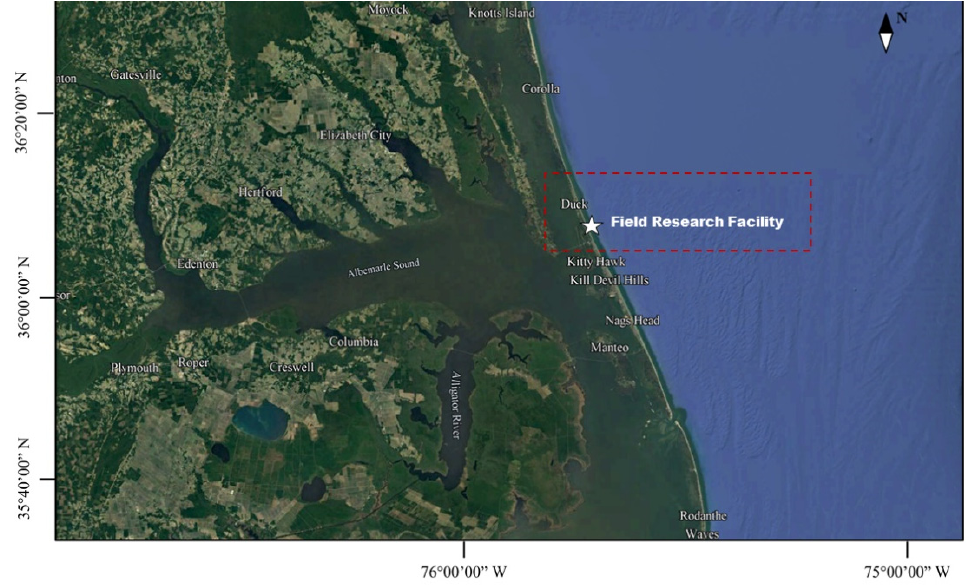
Figure 1. Research area and the location of the Field Research Facility.